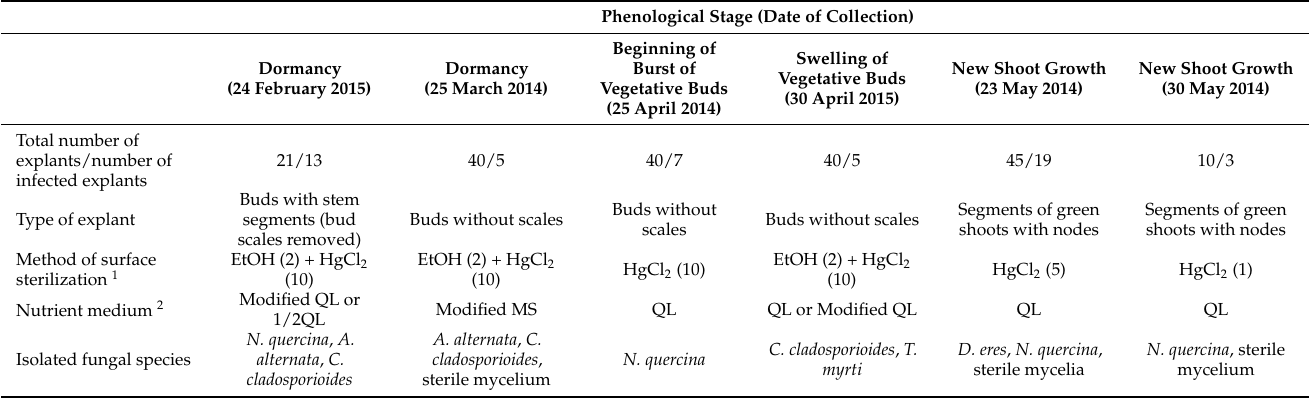
Table 6. Fungal contamination of the apricot explants used for in vitro